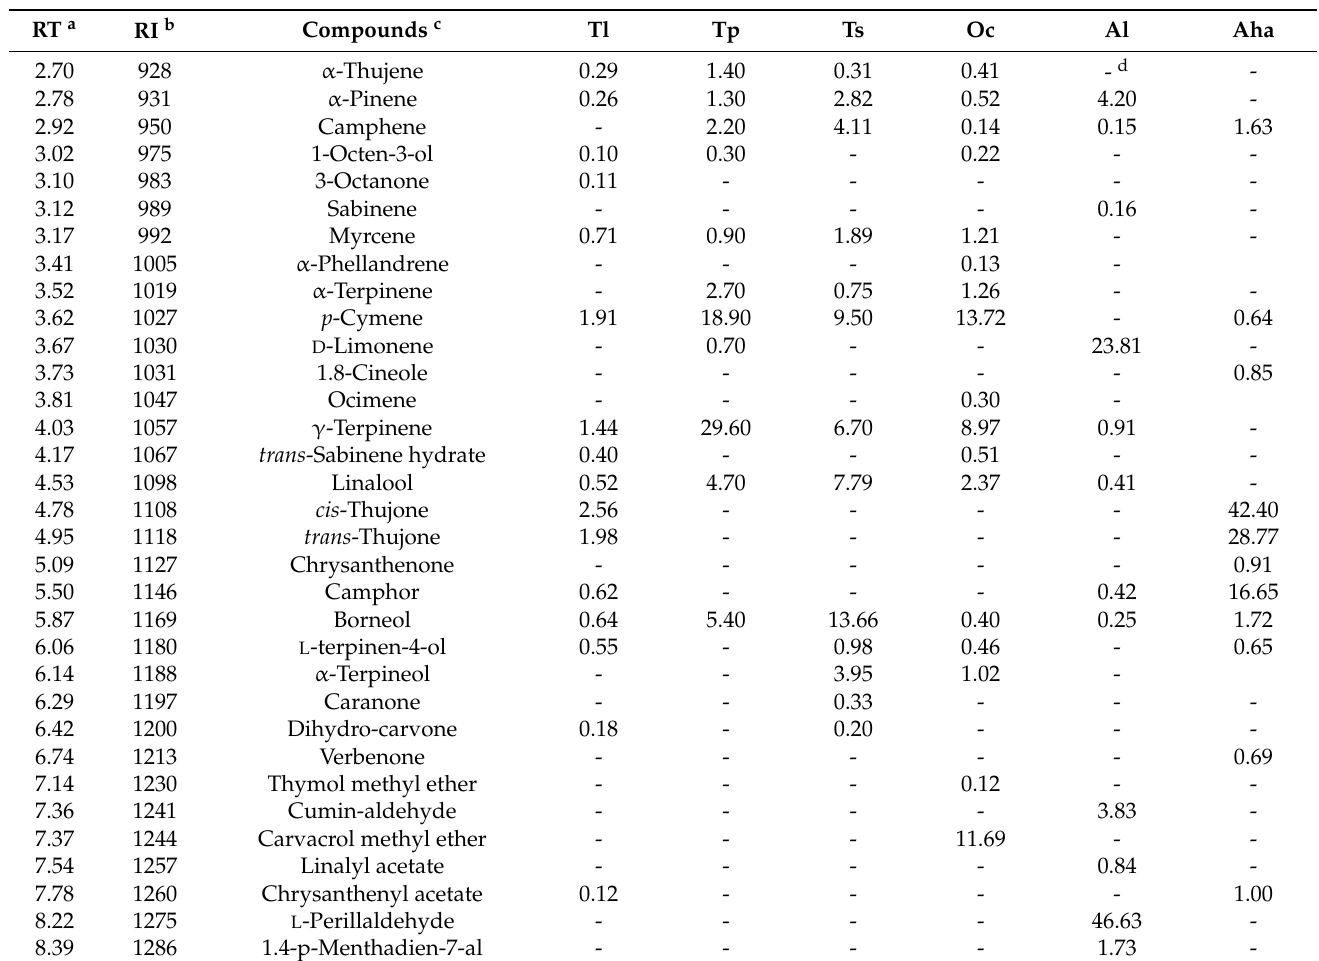
Table 2. Chemical compounds of studied